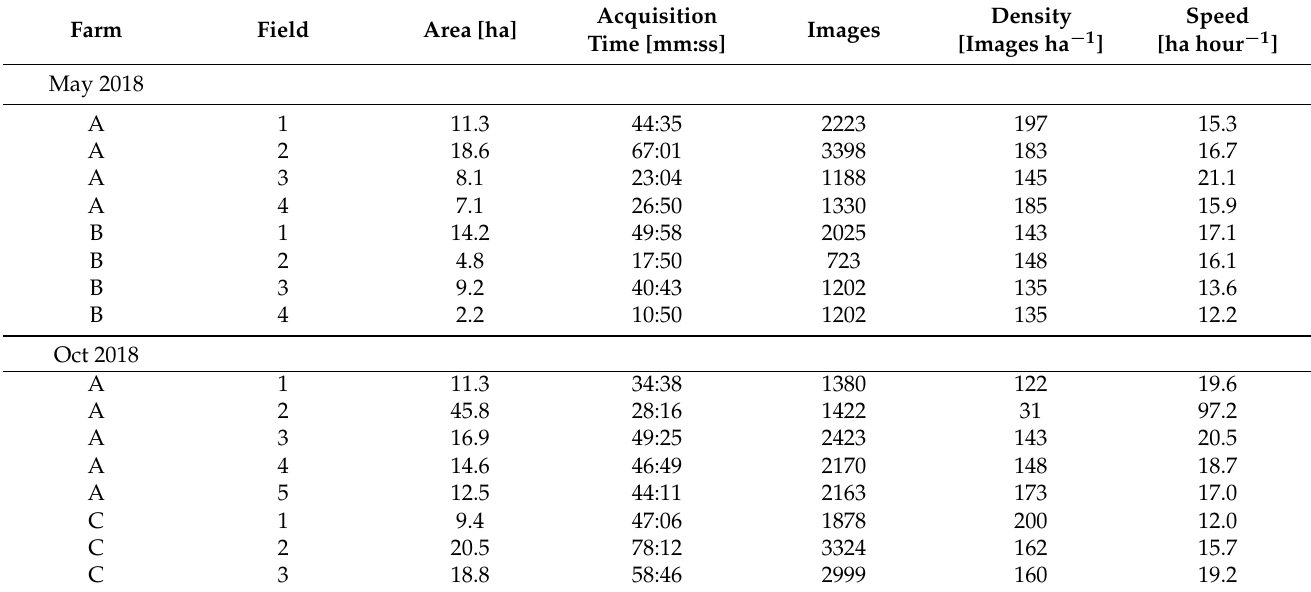
Table 2. Summary of the large scale image acquisition per